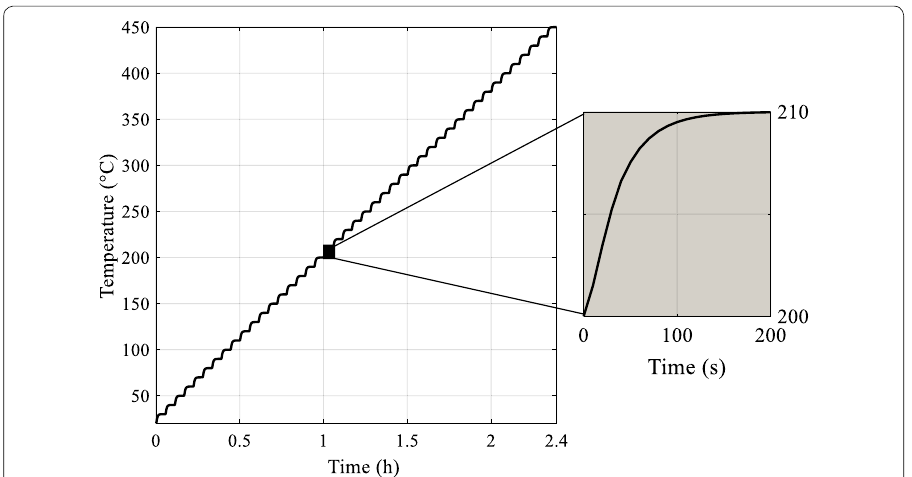
Fig. 2 Evolution of the sample temperature with time in the simulation. The temperature is computed at the middle of the sample using Code_Aster , while temperature is increased step by step from 20 to 450 °C by 10 °C steps. Right inset shows the progressive diffusion of temperature during one step of the deformation process in the simulation (from 200 to 210